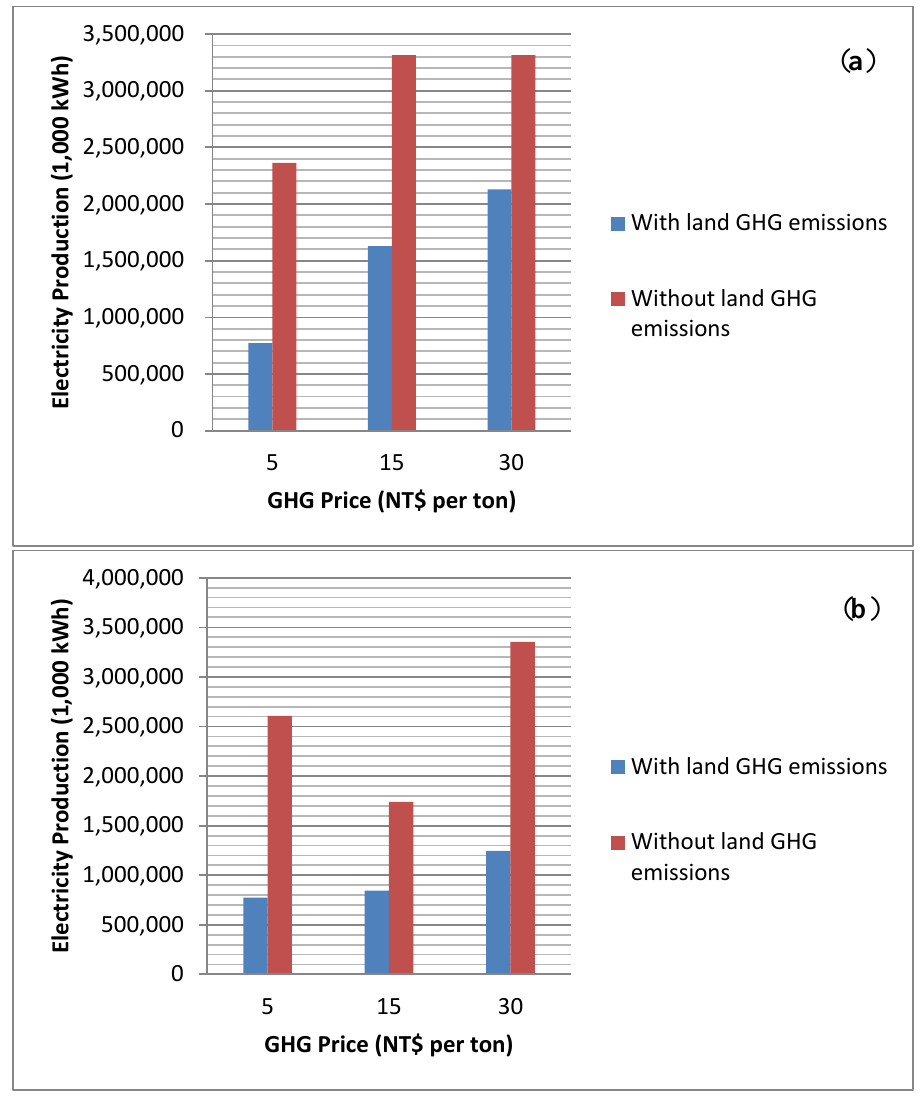
Figure 2. ( a ) Electricity production when biochar is burned for energy; ( b ) Electricity production when biochar is used as a soil amendment. 000